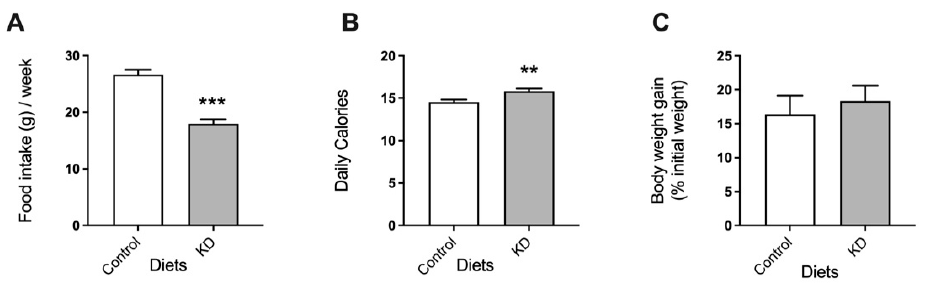
Figure 1. The effect of the experimental diets on ( A ) food consumption, ( B ) calories consumed, and ( C ) body weight. Data shown are the mean ± SEM, n = 7–8/group. **, p < 0.01; ***, p < 0.001, KD versus control.